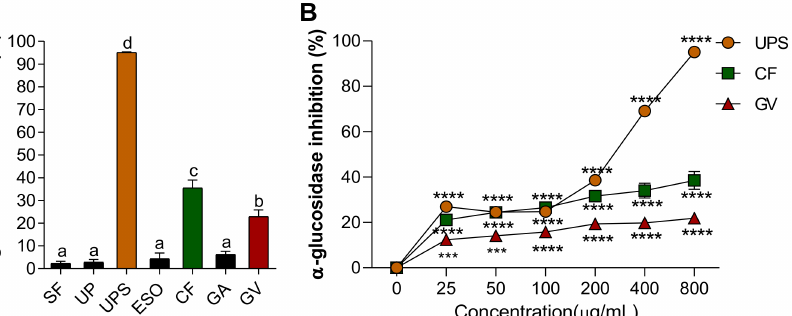
Figure 1. ( A ) Alpha-glucosidase inhibition rate of seven different seaweed extracts. Values that do not share the same superscript are significantly different according to ANOVA ( p < 0.05). ( B ) α - glucosidase inhibition rate of three selected seaweed extracts at various concentrations. All values are presented as the mean ± SEM of three independent experiments ( n = 3–4/group for each experiment); *** p < 0.001, **** p < 0.0001 compared with control group (0 µ g/mL) using one-way ANOVA with Dunnett’s comparison test. Abbreviations: SF, Sargassum fulvellum ; UP; Undaria pinnatifida ; UPS, Undaria pinnatifida sporophyll; ESO, Ecklonia stolonifera Okamura; CF, Codium fragile ; GA, Gelidium amansii ; GV, Gracilaria